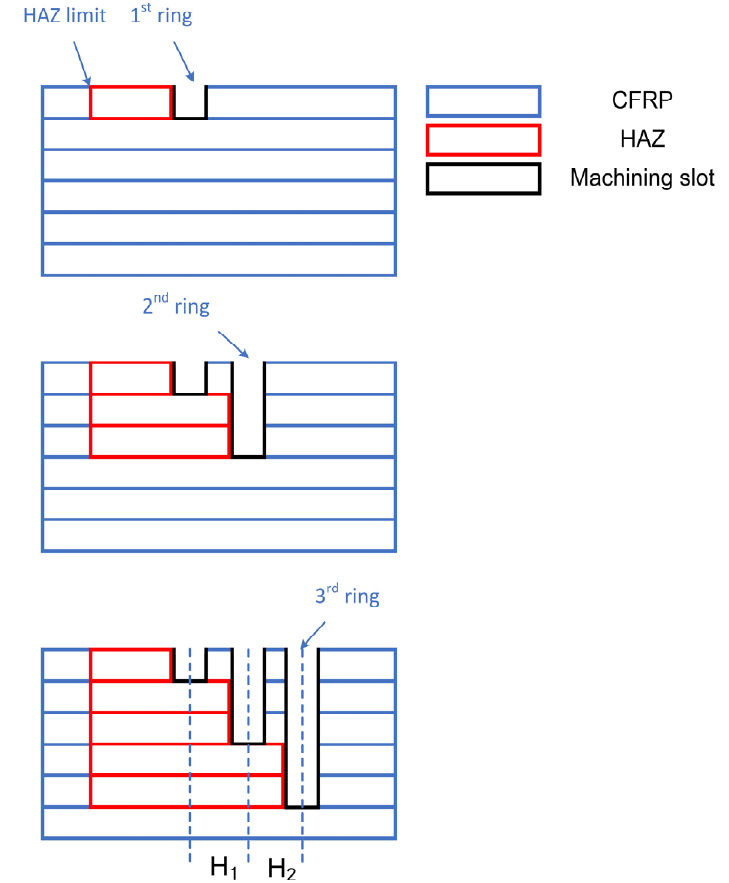
Figure 6. Schematic diagram of stepped laser parameter multiple-ring laser drilling process.